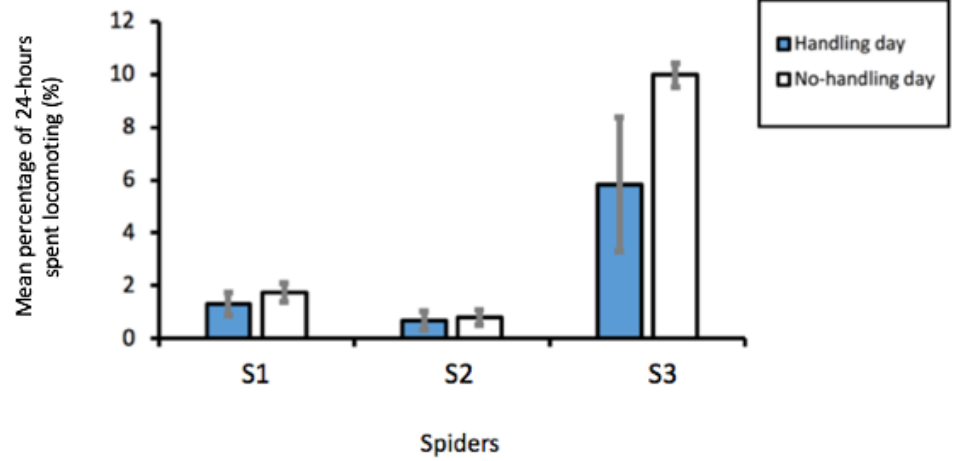
Figure 3. Mean ± SE percentage (%) of handling days (H) and no-handling days (NH) that S1 (8H, 6NH), S2 (6H, 8NH) and S3 (4H, 2NH) spent exhibiting locomotion behaviour.